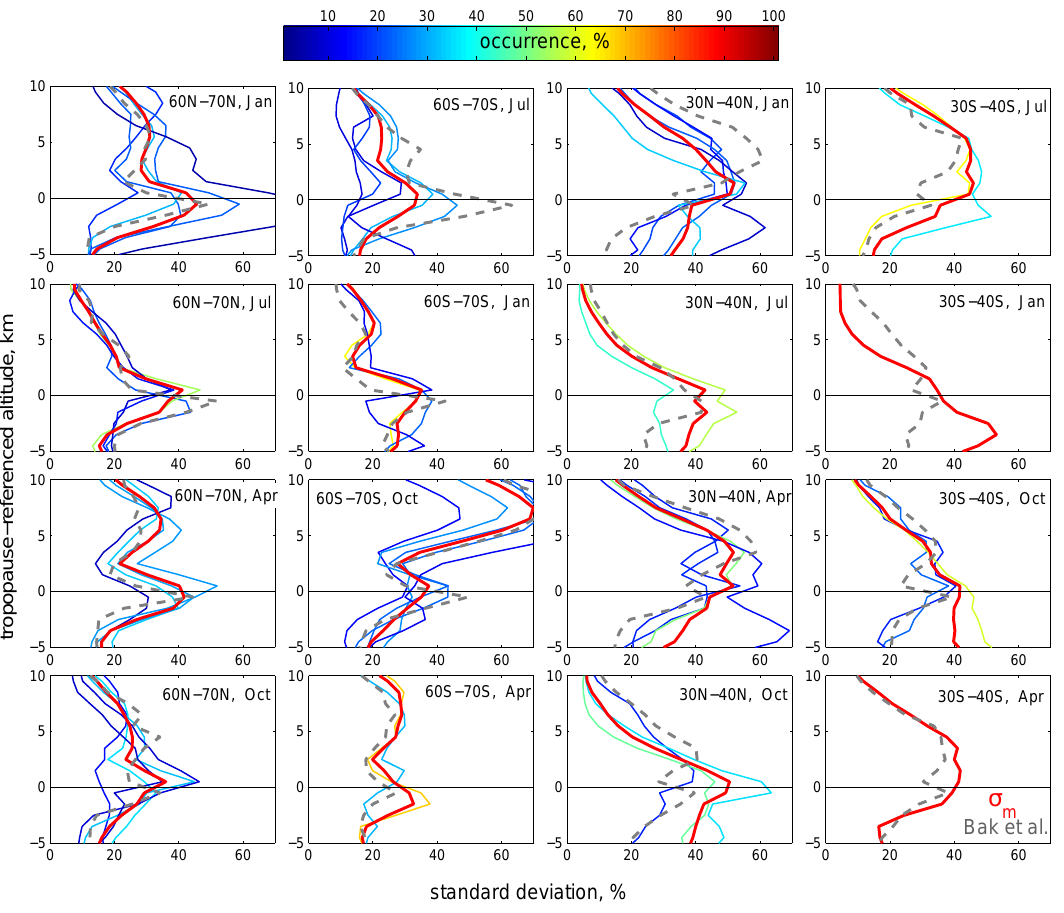
Fig. 12. Variability in UTLS in the tropopause-referenced representation (zero is the tropopause height). Thin colored lines: standard deviation profiles from TpO 3 climatology; color indicates the probability distribution (frequency of occurrence) of the corresponding tropopause height. Red thick lines are the profiles σ m (Eq. 4) corresponding to the downgraded TpO 3 climatology. Grey dashed lines show the standard deviations from the climatology by Bak et al. (2013). Latitude zones and months are indicated in the figure.